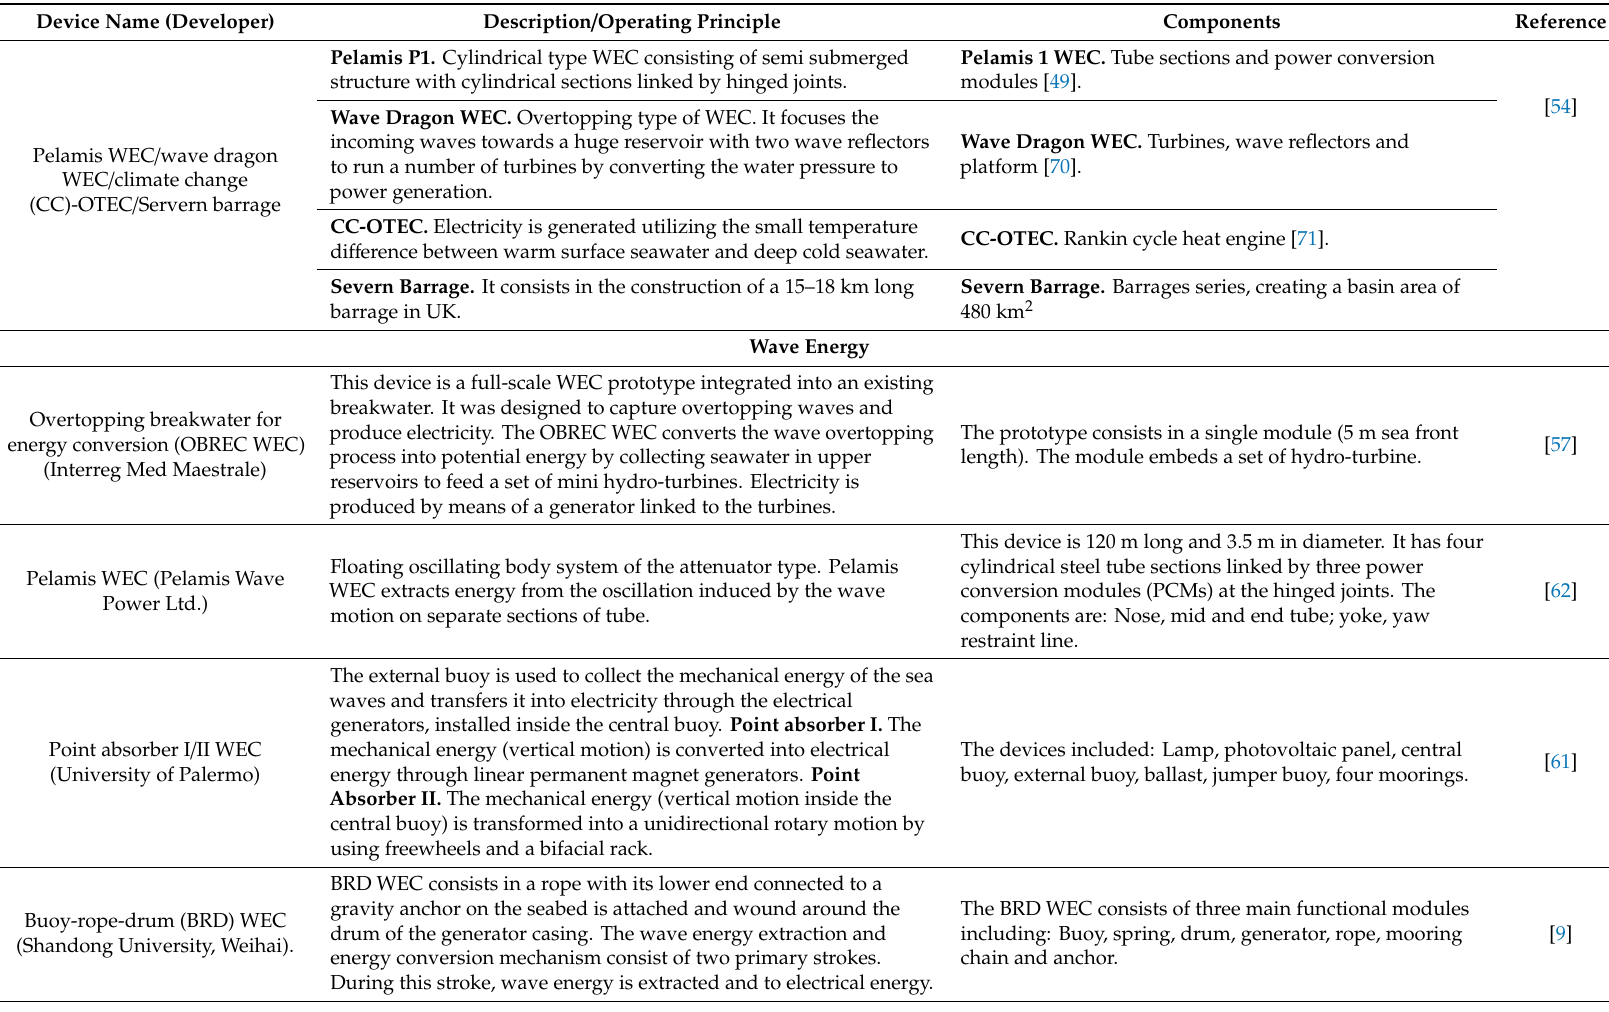
Table 2. Characteristics of the ocean energy devices evaluated in the LCA